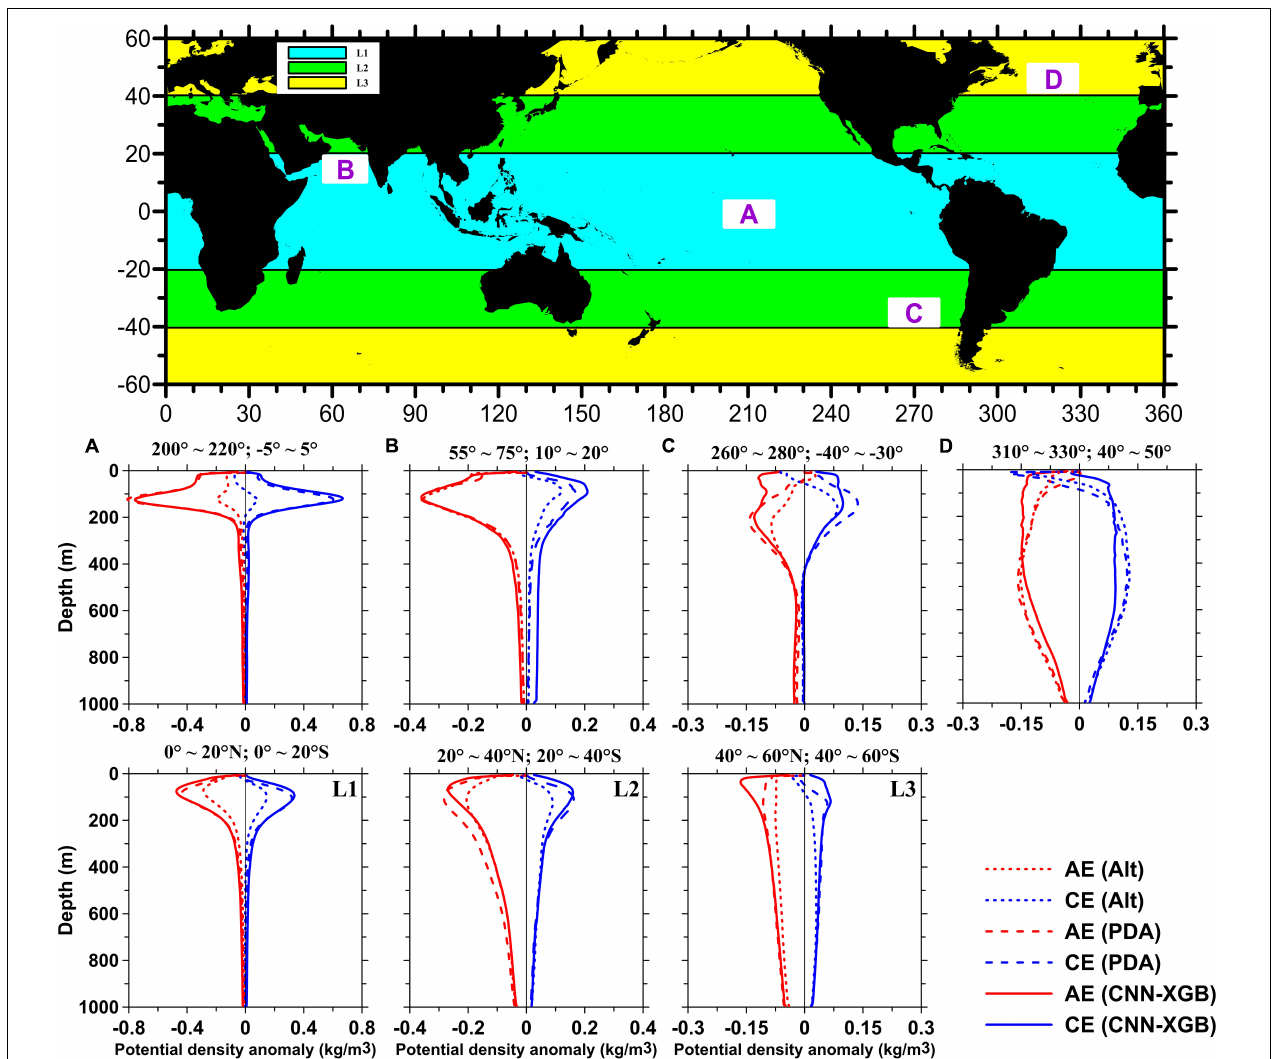
FIGURE 6 | Mean potential density anomaly profiles of four areas in different latitude zones and average profiles of the different latitude zones. The white boxes marked with capital letters in the geographic distribution map represent the location of the corresponding areas, and the bands of different colors represent the corresponding latitude zones. (A,B) Average profiles in areas A and B in latitude 1 (L1: 0 − 20N and 0 − 20S), (C) Average profiles in area C in latitude 2 (L2: 20 − 40N and 20 − 40S), and (D) Average profiles in area D in latitude 3 (L3: 40 − 60N and 40 − 60S). The short dashed red (blue) lines are the profiles of Alt anticyclonic eddies (AE) [cyclonic eddies (CE)], long dashed red (blue) lines are the profiles of potential density anomaly (PDA) AE (CE), and the solid red (blue) lines are the profiles of CNN-XGB AE